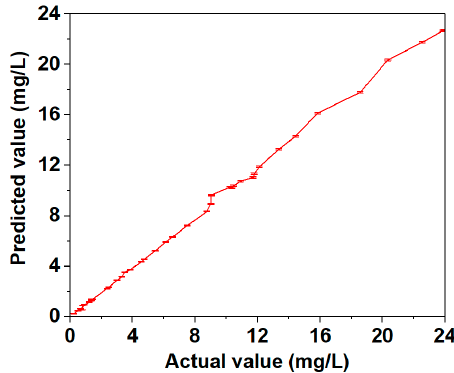
Figure 7. Comparison of the values measured by GC-MS (actual value) and SERS (predicted